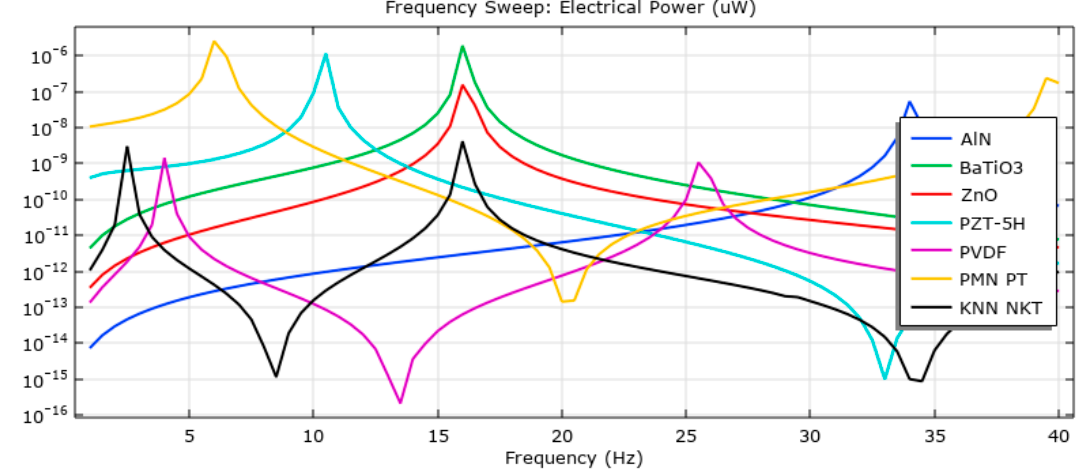
Figure 4. The transverse vibration response of thin film energy harvesters: power output.